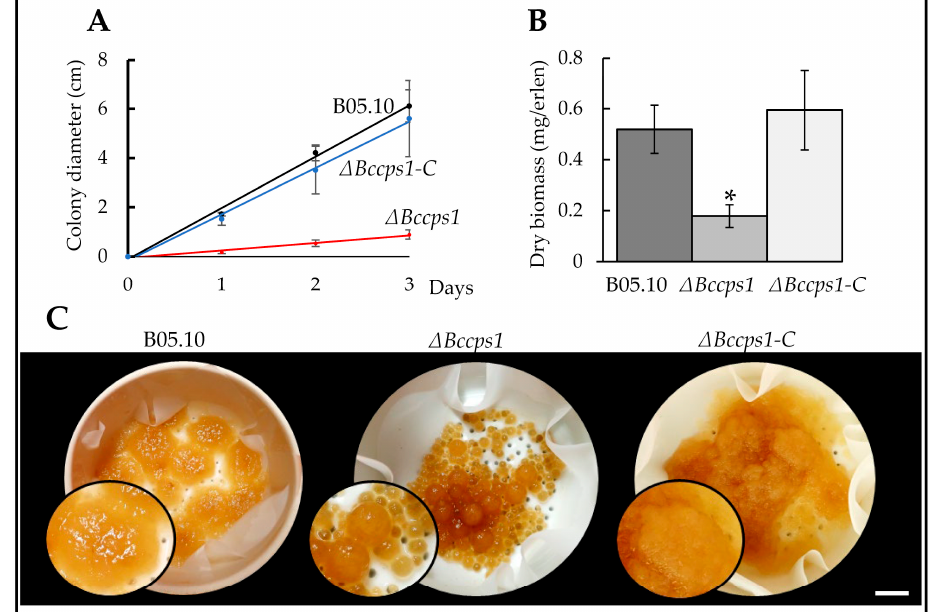
Figure 2. BcCps1 is involved in mycelial growth. ( A ) Radial growth of the parental (B05.10), mutant ( ∆ Bccps1 ) and complemented ( ∆ Bccps1 -C) strains on a solid rich medium over time. ( B ) Growth of the parental, mutant and complemented strains in a liquid rich medium. The biomass was weighed at day 3. ( C ) Images of the mycelial pellets collected by filtration of the liquid cultures at day 3. Black dots among the pellets are the funnel holes visible through the wet filter paper. Magnifications are shown in black circles. Scale bar: 1 cm. Stars indicate significant differences ( T -test bilateral; p <